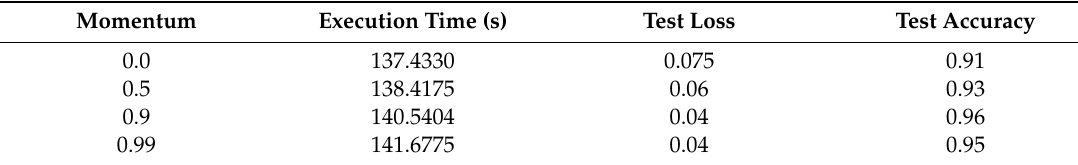
Table 21. E ff ect of momentum on SNN.